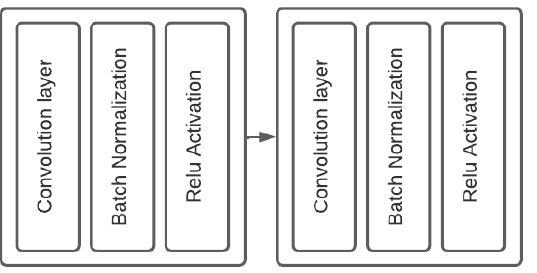
Figure 4. Double convolution Block, using kernel size 3 for all convolution layers, padding 1 and stride is 0 and the double convolution output in order (64, 128, 512, 1024).